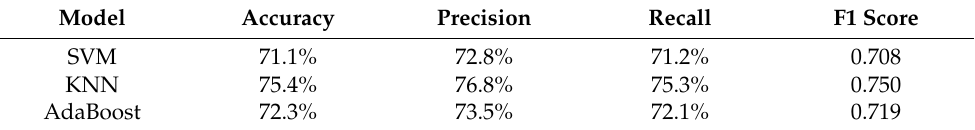
Table 17. Results for classification models when trained using the physical appearance